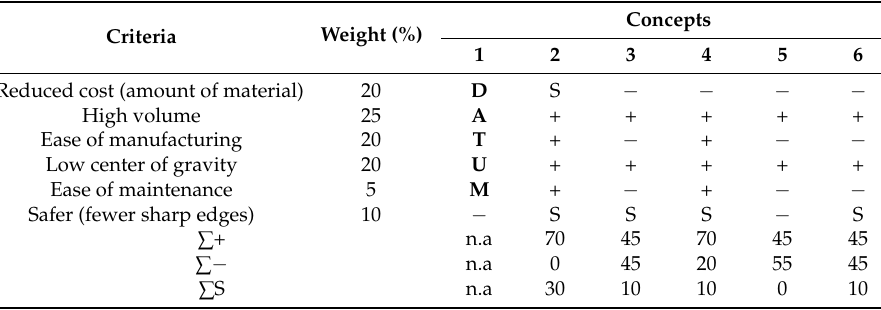
Figure 4. Concepts generation for the tank design. Table 1. First-round decision matrix for tank design